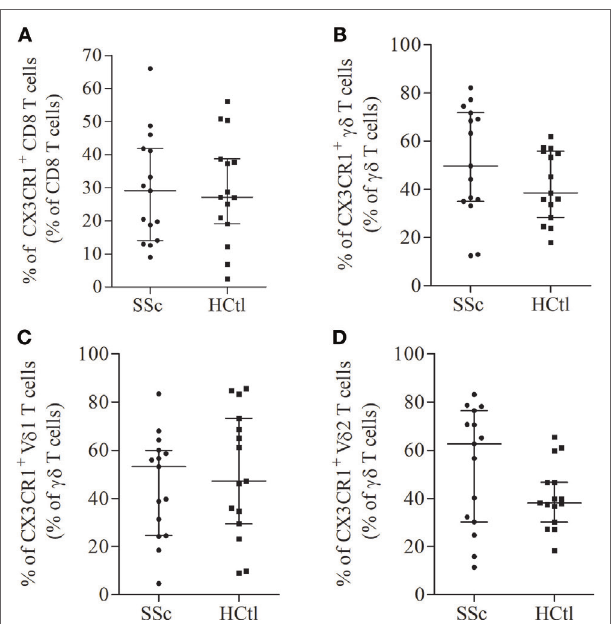
FigUre 3 | CX3CR1 expression in circulating cytotoxic immune cells from systemic sclerosis (SSc) patients. Percentages of CX3CR1 expressing immune cells were evaluated with flow cytometry analysis on the surface of CD8 T cells (a) ; γδ T cells (b) ; V δ 1 (c) ; and V δ 2 T cells (D) from SSc patients ( n = 15) in comparison with healthy controls (HCtl) ( n = 15). Results were expressed as median percentages and median ± interquartile range.